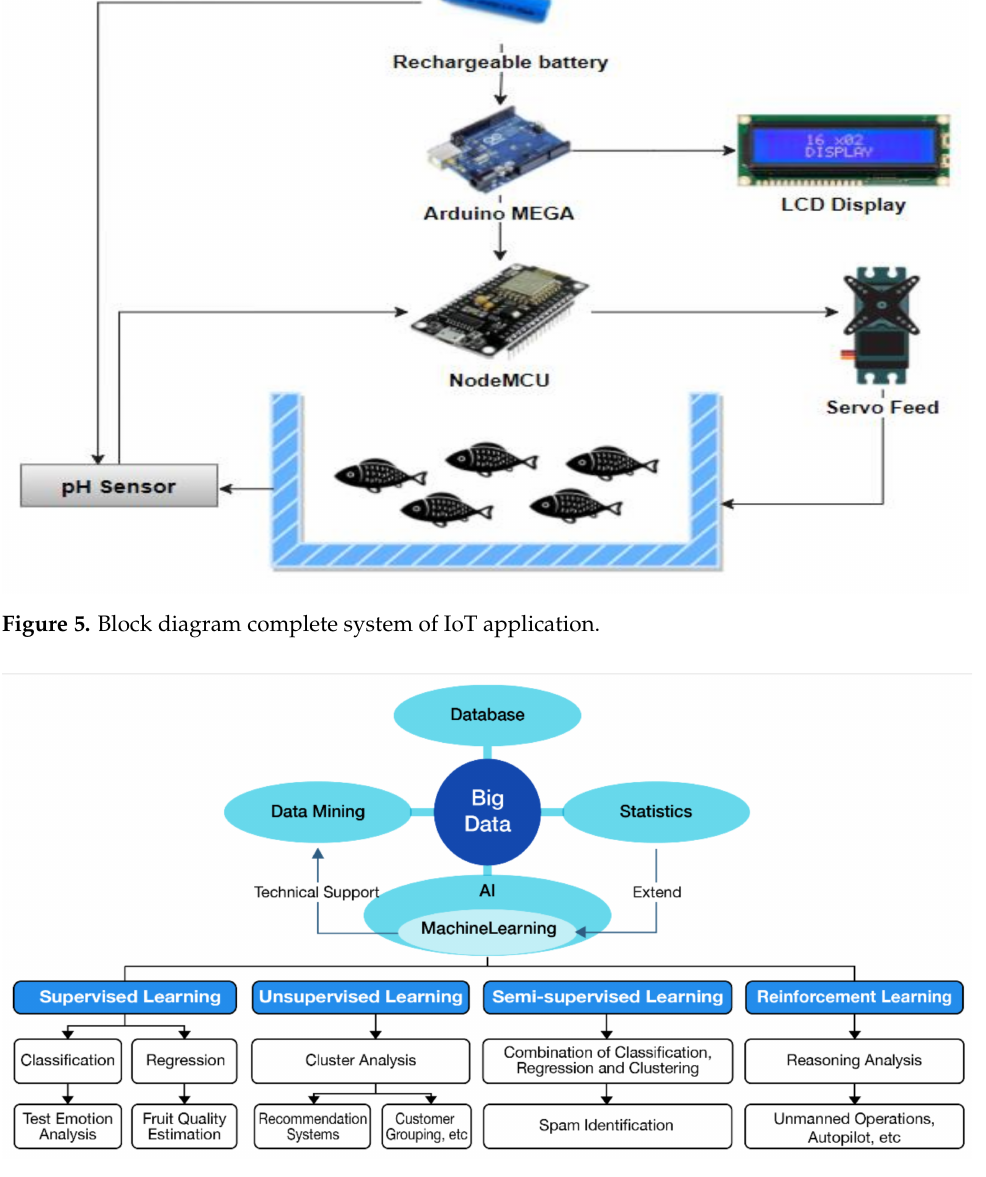
Figure 6. The relationship between the four types of machine learning and common